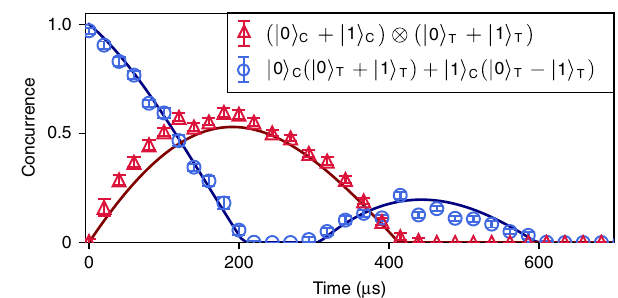
Fig. 5 Undesired entanglement induced by the coupling ancilla. Concurrence vs. wait time for an initially separable state (red) using single- photon encoding, and for an initial Bell state (blue) obtained by applying the CNOT gate to the separable state. The presence of the cross-Kerr interaction between the two cavities is responsible for the observed oscillatory behavior, whereas dephasing due to thermal excitations in the ancilla results in a gradual decay of the entanglement. By fi tting simulations (solid curves) to the measured data, we determine a cross-Kerr interaction rate of χ CT /2 π = 2 kHz. Error bars indicate the standard error derived